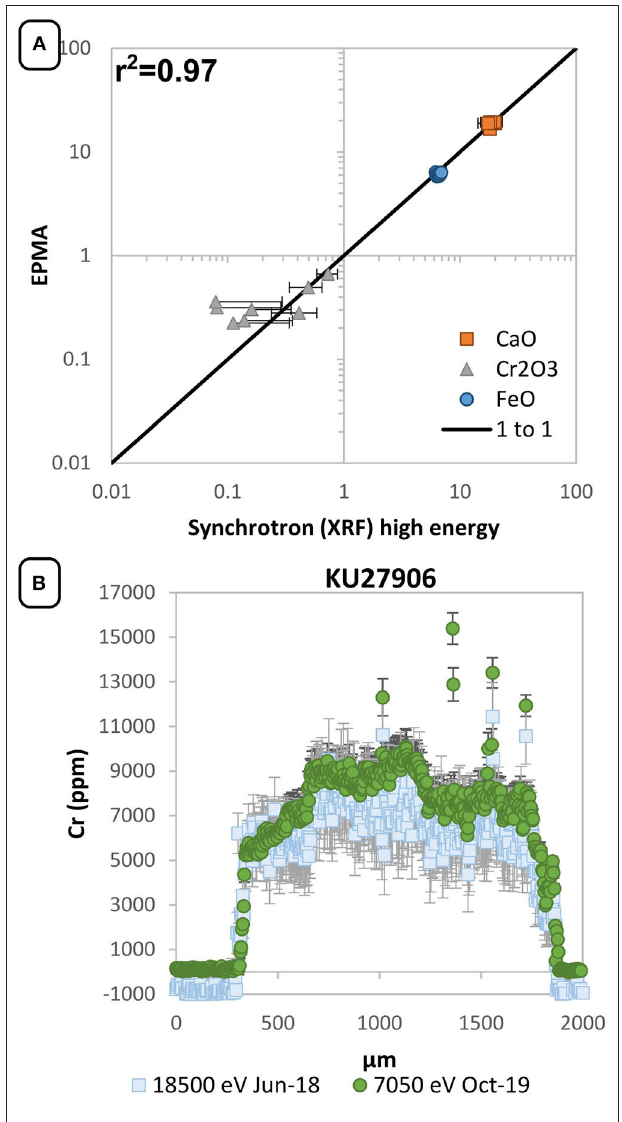
FIGURE 2 | (A) A comparison between the major elements calculated from the Synchrotron Maia Detector from the high energy experiment (18,500eV) with the EPMA analysis from sample KU30024. (B) Sample KU27906 ( Figure 7 ) was measured in both the 18,500eV experiment and the low energy (7,050ev) experiment and the results are comparable, with Cr precision increasing using the low energy